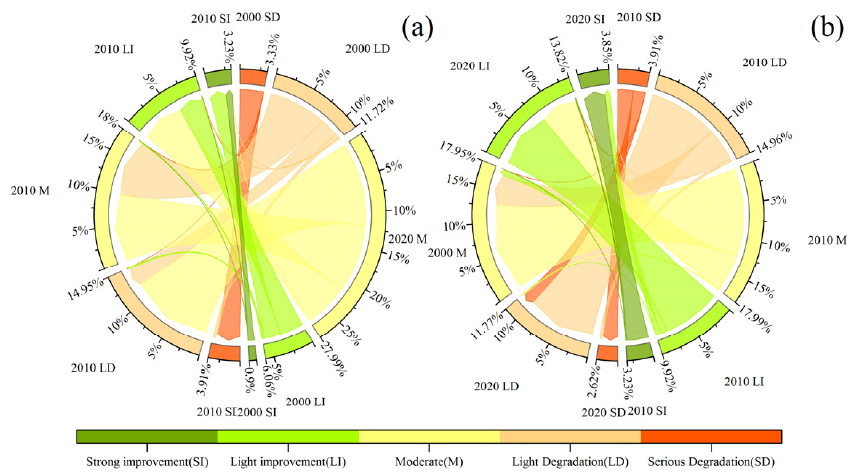
Figure 5. Sankey of RSEI transfer matrix from ( a ) 2000–2010 and ( b ) 2010–2020.